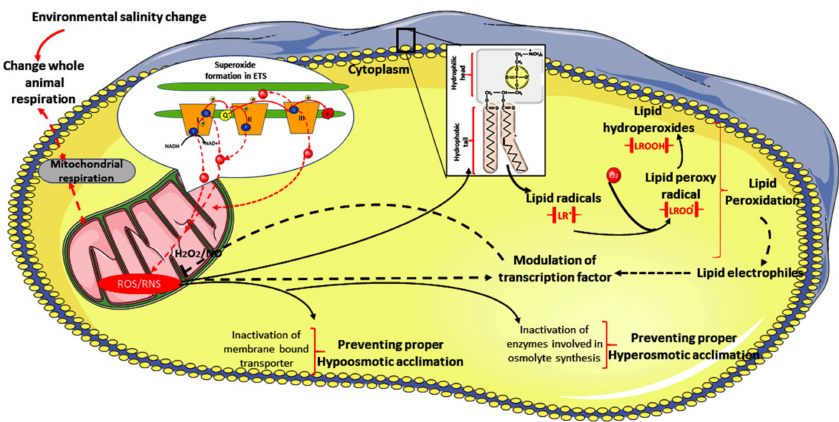
Figure 6. Responses of mitochondria to changing salinity: When mitochondria experience changes in the osmotic pressure in the cell due to environmental ionic strength, it may lead to electron transport chain dysfunction, thereby resulting in more electron accumulation in the intermembrane